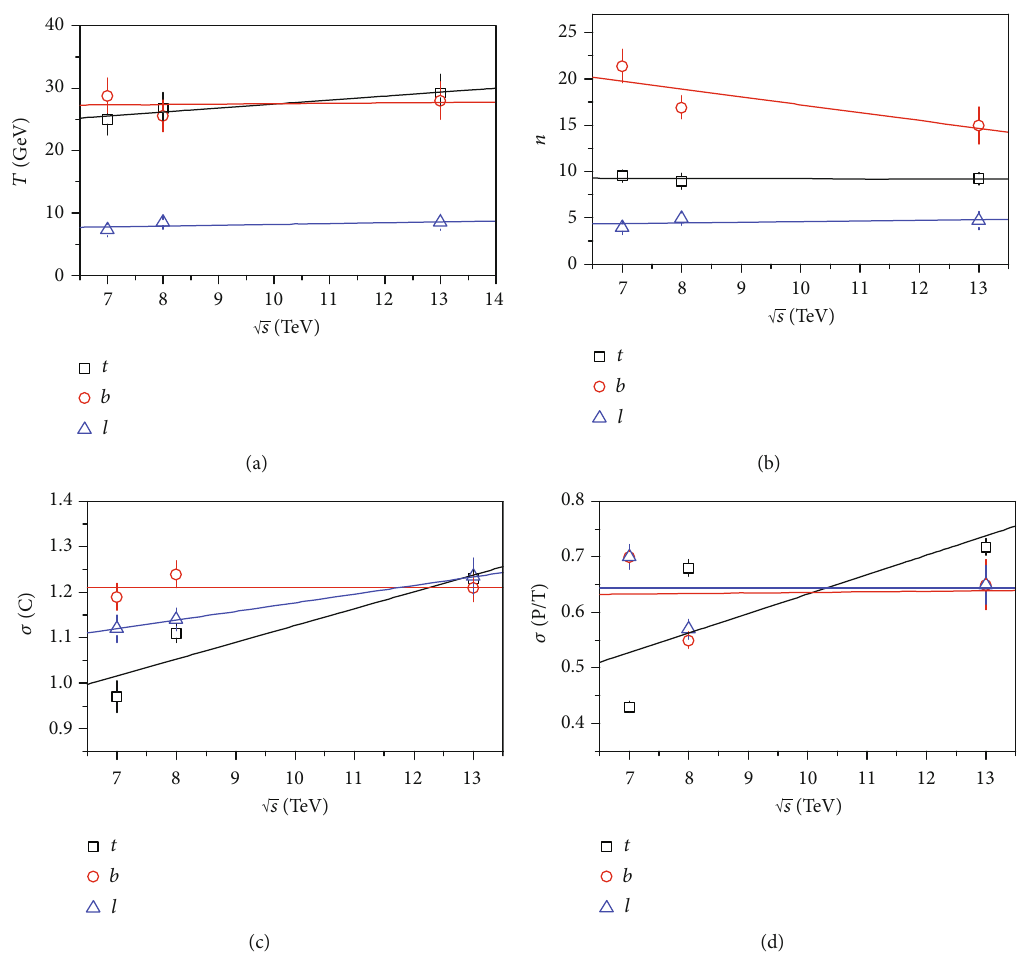
Figure 17: The relationship of the free parameter and collision